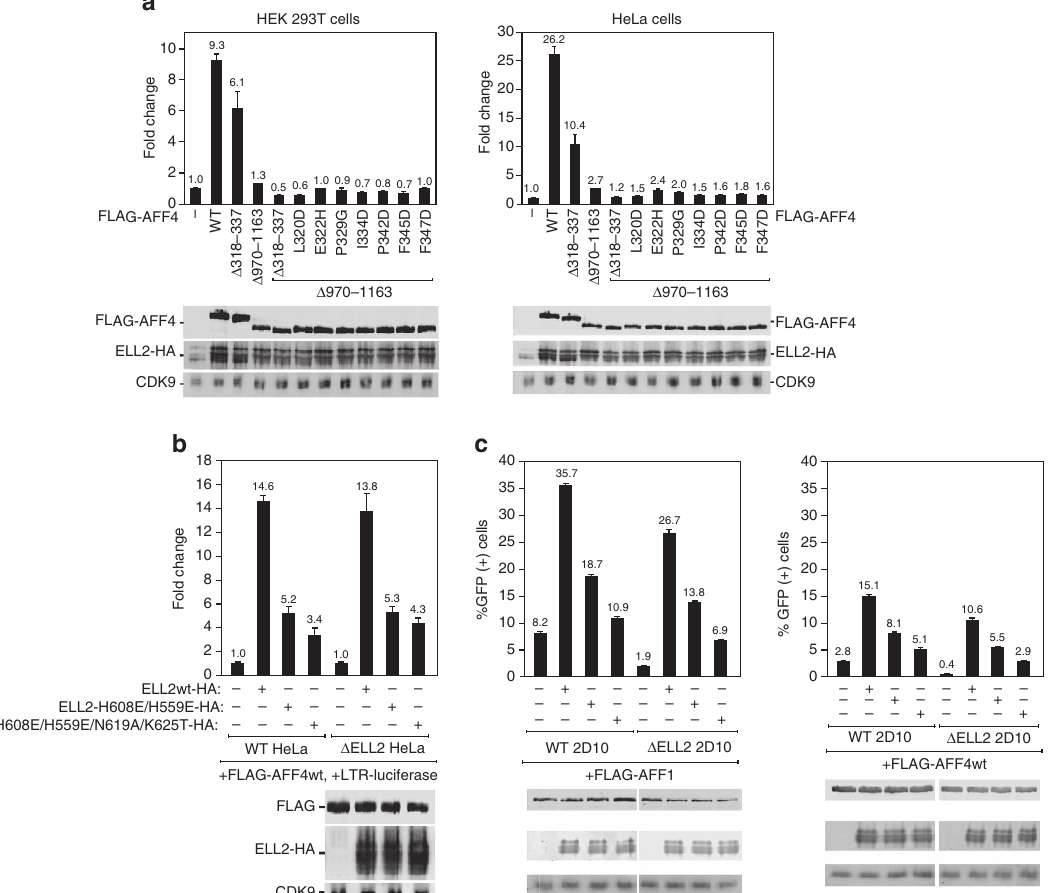
Figure 7 | The ELLBow-binding site of ELL2 is important for HIV-1 long terminal repeat (LTR) transcription. ( a , b ) Luciferase activities were measured and analysed in extracts of cells transfected in triplicate with the HIV-1 LTR-luciferase construct together with the combinations of plasmids expressing wild-type and mutant ELL2-HA and FLAG-AFF4 as indicated. Each of the ELL2 and AFF4 plasmids was transfected at 1 m g per well. The activities in the control groups were set to 1. The error bars represent mean ± s.d. from triplicate wells. An aliquot of each cell extract was examined by immunoblotting for presence of the various proteins labelled on the left. ( c ) Jurkat 2D10 cells were nucleofected in triplicates with plasmids expressing AFF1 (top) or AFF4 (bottom) alone or in combination with ELL2wt or its mutants as indicated. 48h post nucleofection, the percentages of GFP þ cells were measured by flow cytometry and plotted. The error bars represent mean ± s.d.’s. The levels of the indicated proteins in nucleofected cells were determined by immunoblotting. Uncropped versions of the blots are shown in Supplementary Fig.